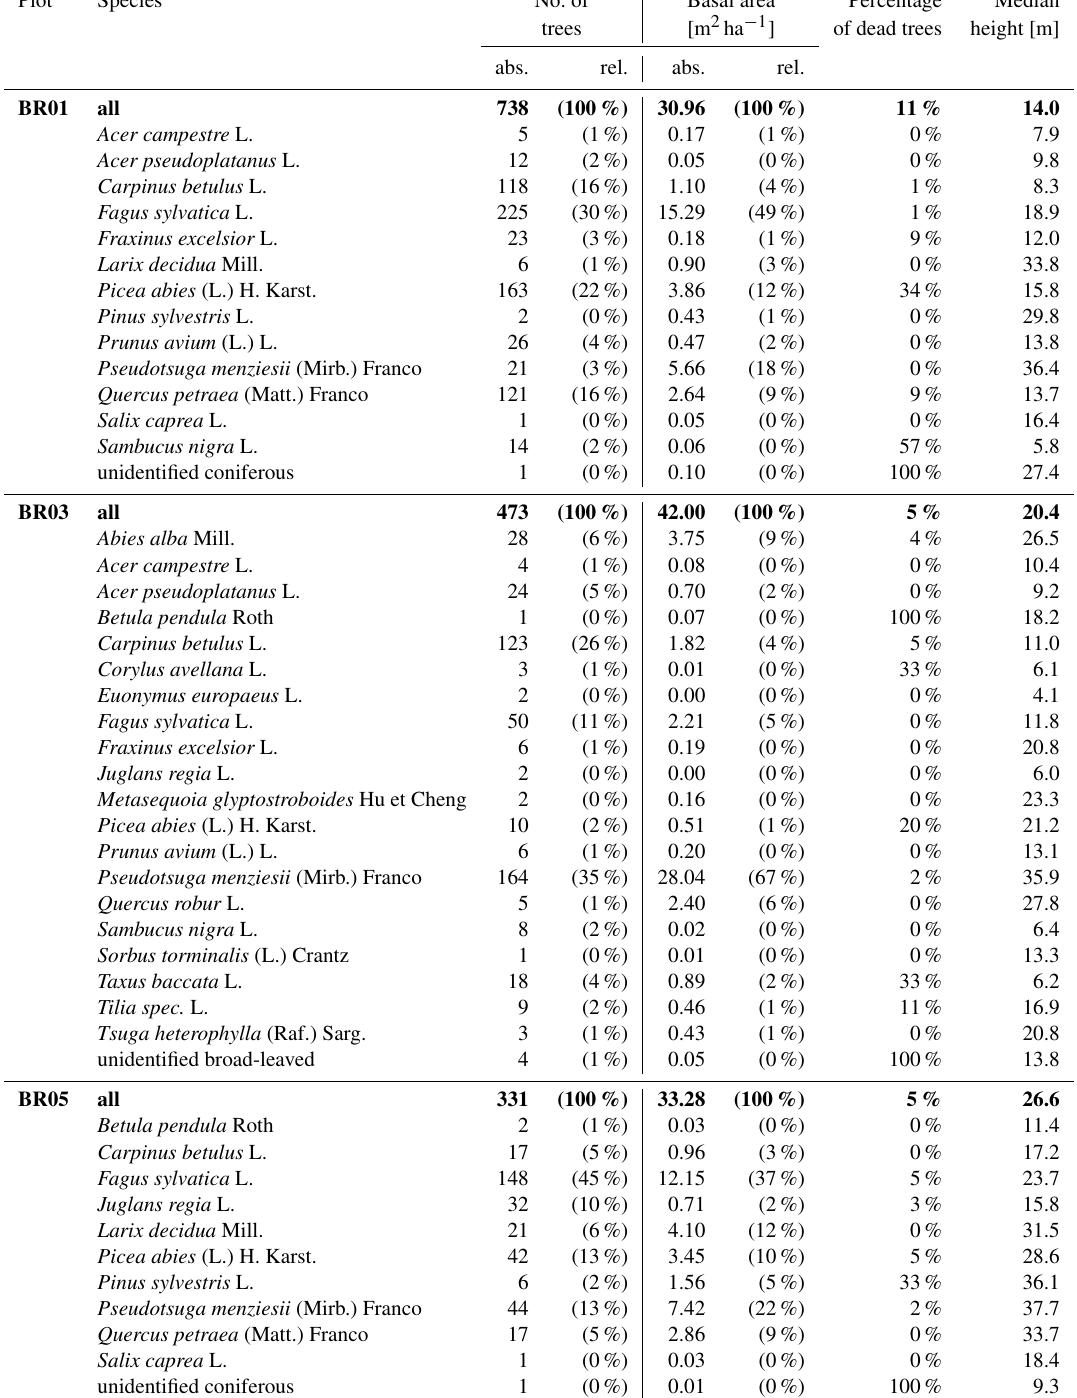
Table A1. Forest characteristics of full inventory plots of 1ha. Values are given for all trees in the plot (bold) and for trees of each species separately. For the number of trees and the basal area, both absolute (abs.) and relative (rel.) values are provided. It should be noted that point clouds were not extracted for every tree in these